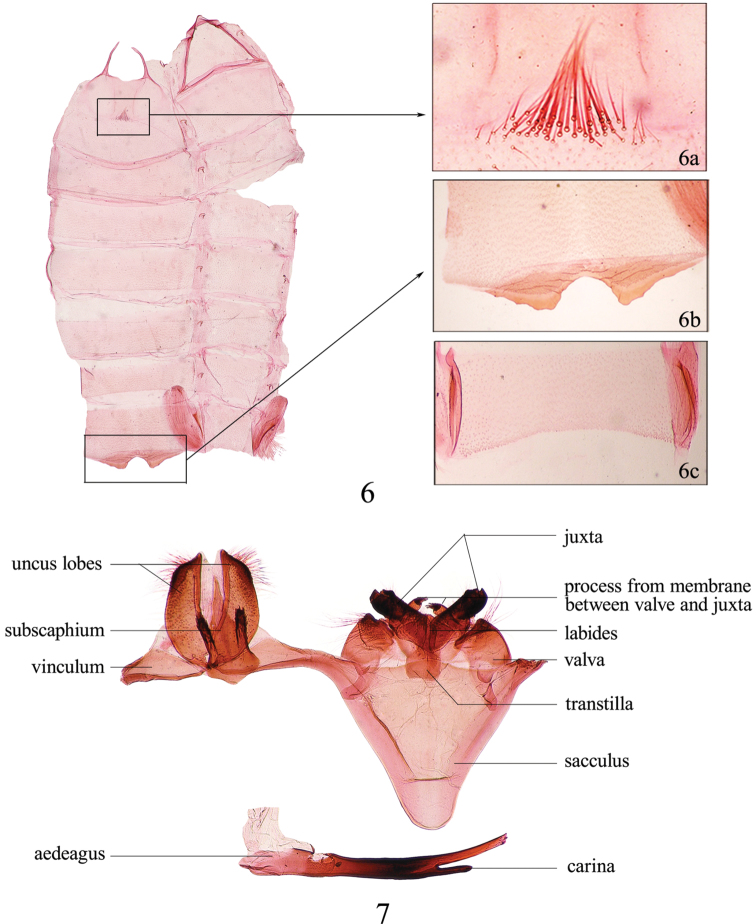
Male abdomen of Tinissa indica Robinson. 6 Pregenital abdomen: 6a setae on second sternite 6b−6c eighth sternite 7 male genitalia (6a−b, 7 slide No. NKYLL012; 6c
Tinissa connata sp. n., slide No. YLL11167).